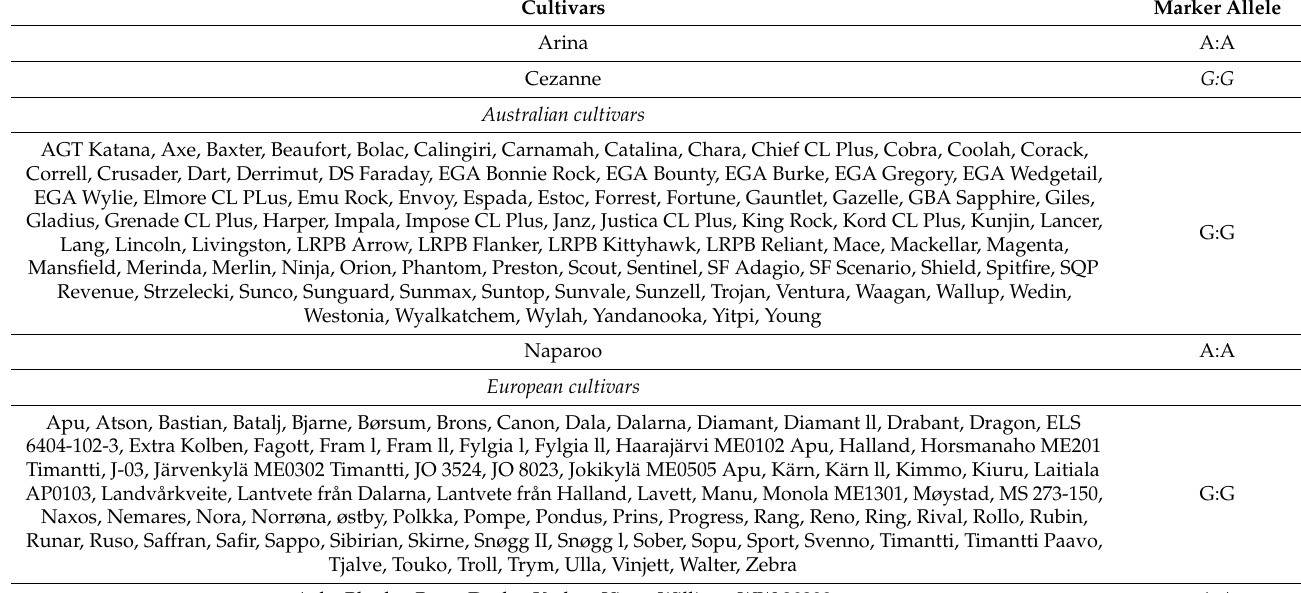
Table 3. Genotyping of diverse wheat germplasm using Sr48 -linked marker sunKASP _239. Cultivars Marker